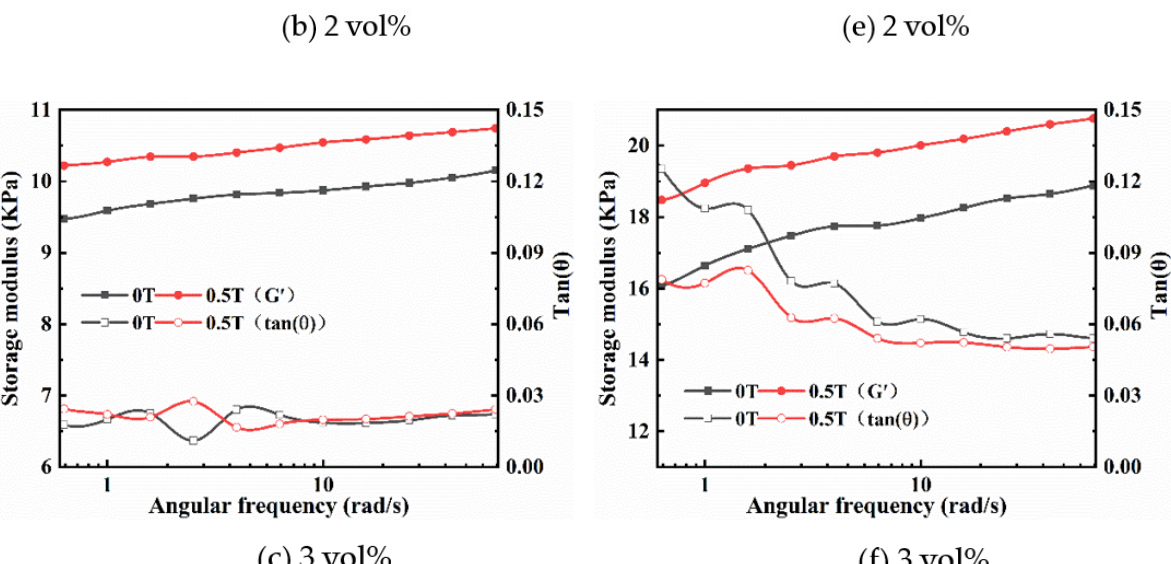
Figure 4. Angular frequency dependence of the G’ and tan δ of isotropy ( a – c ) and anisotropy ( d – f ) samples with Fe 3 O 4 of 1 vol%, 2 vol% and 3 vol% under 0 T and 0.5 T at a fixed strain amplitude of 0.1 %.